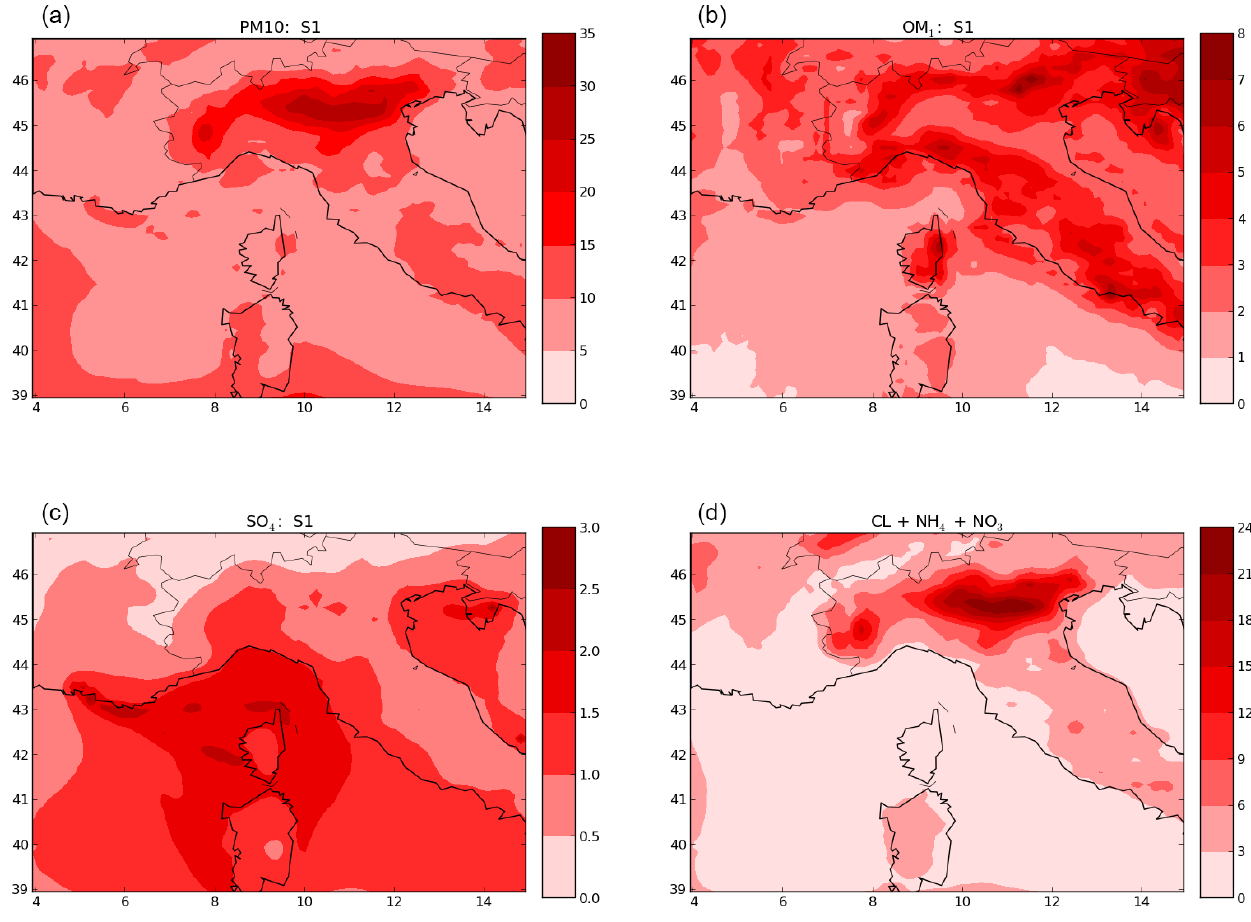
Figure D1. Maps of the concentrations of PM 10 (a) , OM 1 (b) , PM 10 sulfate (c) and other PM 10 inorganics (ni- trate + ammonium + chloride) (d) during the summer 2013 in µgm − 3